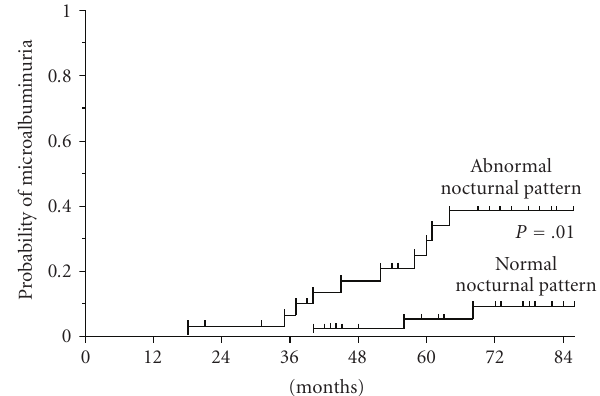
Figure 5: Kaplan-Meier curves showing the probability of microal- buminuria according to the pattern of daytime and nighttime systolic pressure. The probability of microalbuminuria di ff ered significantly between the two groups ( P = . 01 by the log-rank test). The risk of microalbuminuria was 70% lower in the subjects with a normal nocturnal pattern (adopted from [16]).